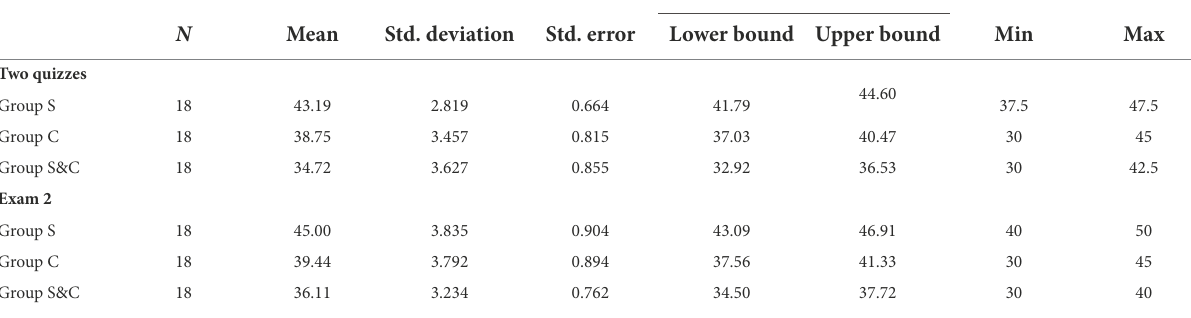
TABLE 3 Means, standard deviations, and range of acquisition of procedural knowledge for phase